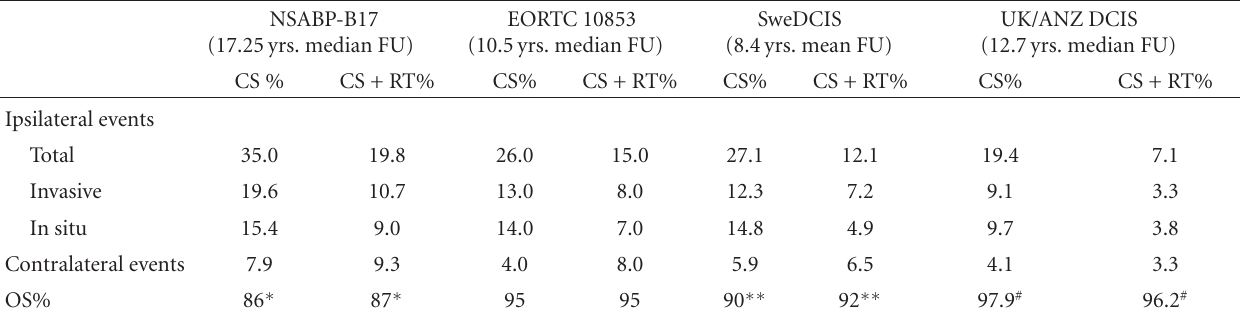
Table 2: Comparison of breast cancer events in prospective randomized